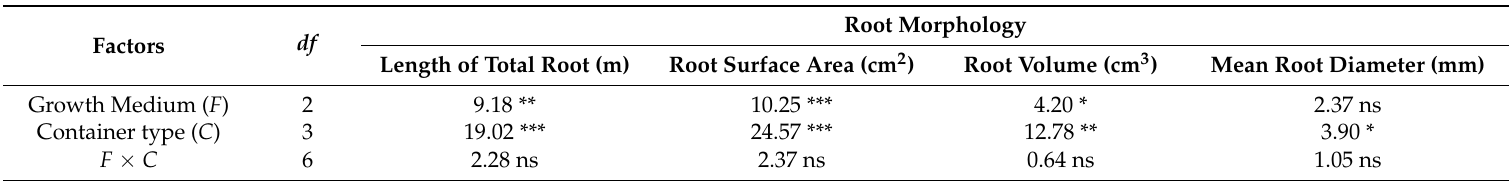
Table 4. F -values and probability levels from the GLM (general linear model) analysis of root morphology of Cyclocarya paliurus seedlings.